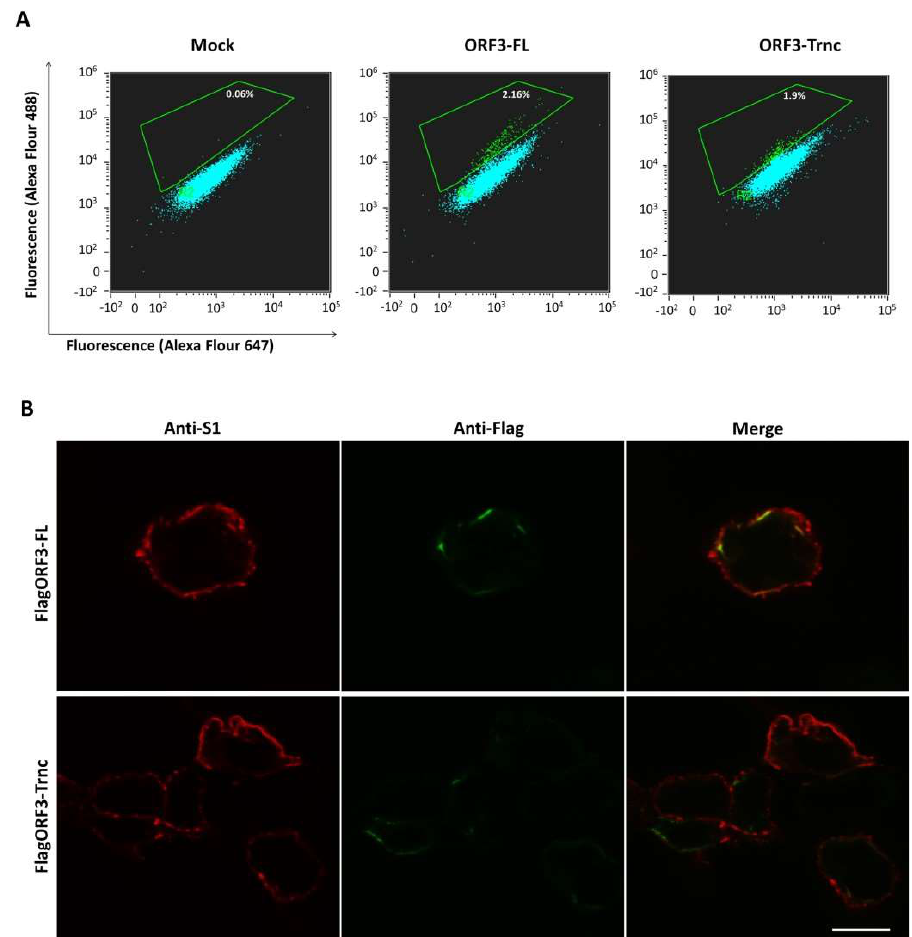
Figure 5. Subcellular localization of PEDV ORF3 protein on the plasma membrane. HEK293T cells were transfected with pCAGGS_FlagORF3s (FlagORF3-FL or-Trnc). At 24 hpt, cells were harvested and prepared under non-permeabilization condition; ( A ) the increased fluorescence signal against Flag-epitope was determined by flow cytometry. The percentage was calculated with respect to the whole cell population. Average transfection efficiency of HEK293T is approximately 80–90%; ( B ) the plasmid expressing S AV12 was co-transfected with pCAGGS_FlagORF3s in HEK293T cells grown on coverslips. Cells were prepared under non-permeabilization condition. Co-localization of PEDV FlagORF3 with S proteins was analyzed by confocal microscopy. Rabbit anti-Flag epitope or mouse anti-S1 antibodies and goat anti-rabbit IgG Alexa flour 488 or-mouse IgG Alexa flour 647 were used as primary and secondary antibodies, respectively. Scale bars are 10 µm.